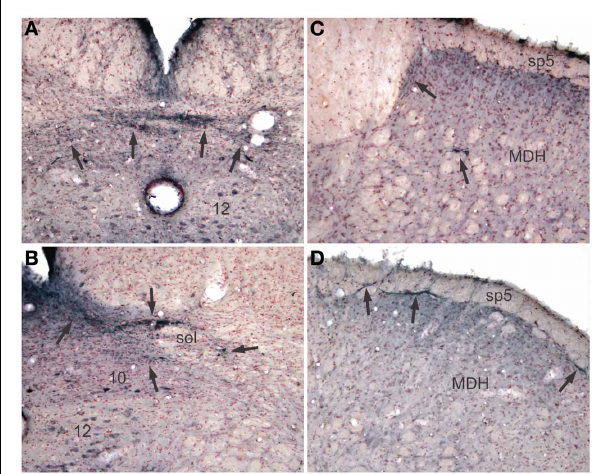
FIGURE 4 | Pericardial injections of CTB also induced transganglionic transport in sensory fibers. Note black precipitate (arrows) in the commissural subnucleus ( A , arrows) and dorsolateral and ventrolateral subnuclei ( B , arrows) of the nucleus tractus solitarii; such label mimics that seen after labeling primary afferent fibers innervating baroreceptors and the trachea. Labeling of sensory afferent fibers was also noted in the C 1 spinal segment (C) and medullary dorsal horn (MDH) of the trigeminal sensory complex (D) in laminae I and IV–V